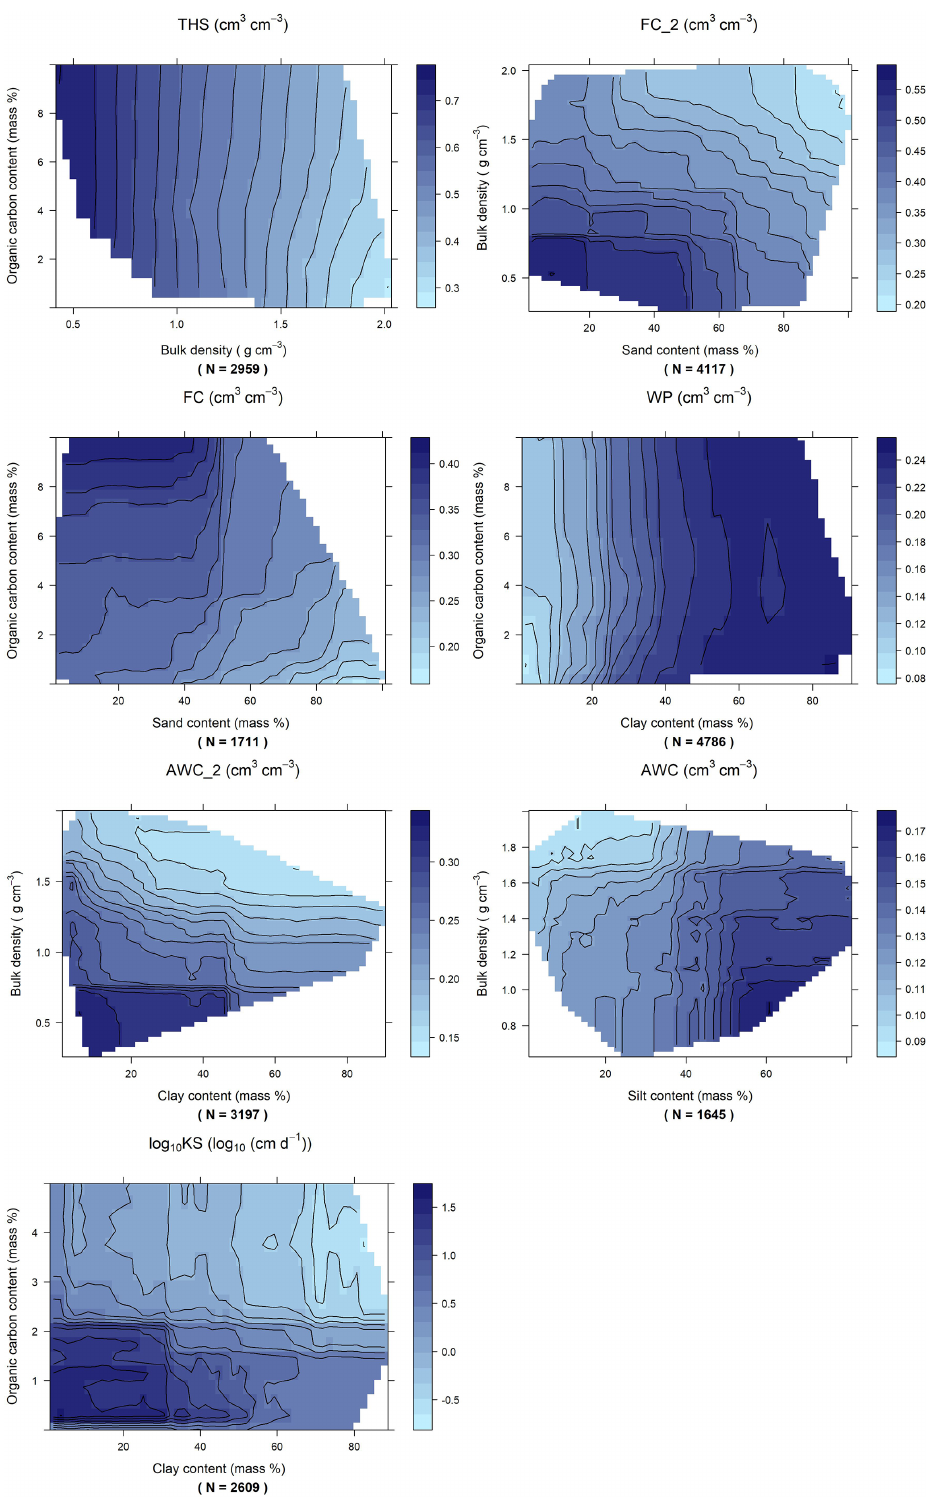
Figure 4. Partial dependence plot computed based on the random forest algorithm (PTF07) for the prediction of water content at saturation (THS), field capacity at − 100 (FC_2) and − 330 (FC) matric potential head, wilting point (WP), plant available water content computed with field capacity at − 100 and − 330cm matric potential head (AWC_2, AWC) and saturated hydraulic conductivity (KS) for selected